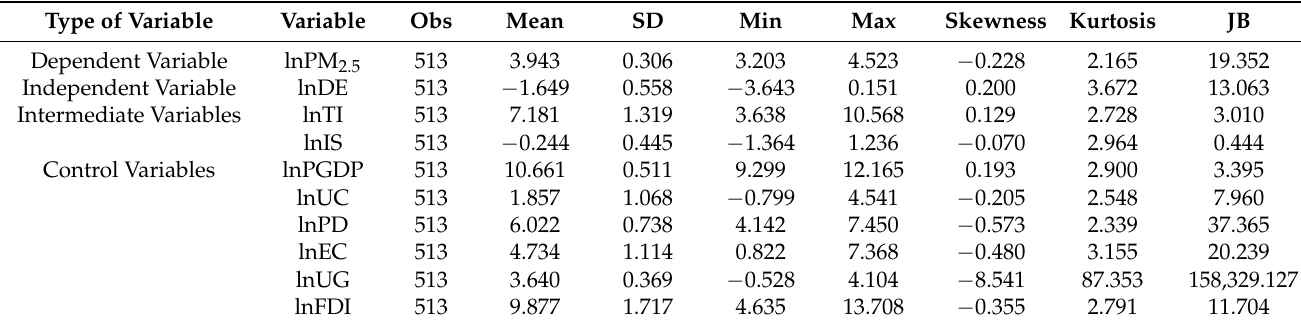
Table 2. Descriptive statistics of the